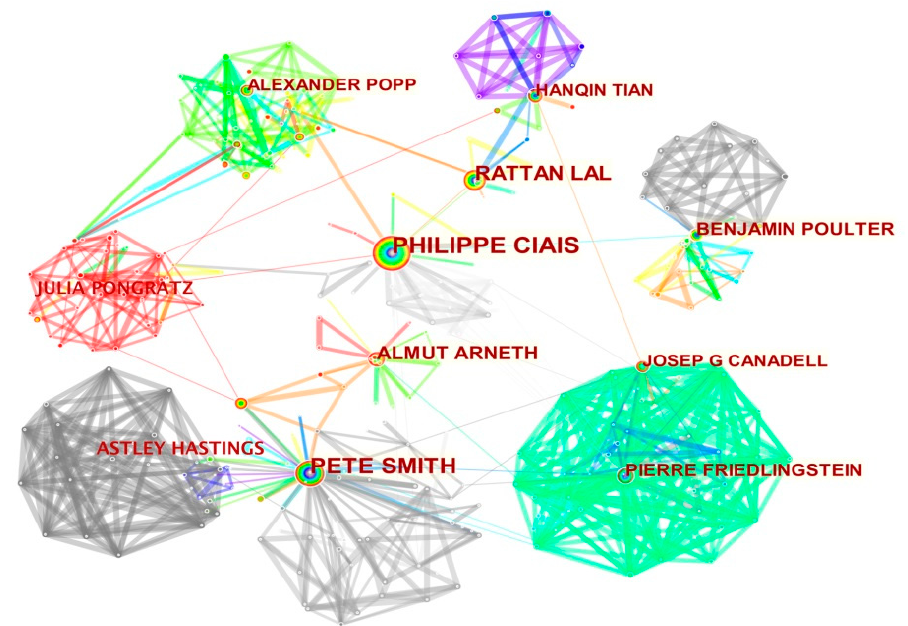
Figure 5. The collaborative network of authors for carbon emissions research in the WoS database. Based on the CNKI database, the authors’ cooperation network graph with a net- work density of 0.0032, a node number of 417, and a connection number of 281 were obtained. According to Figure 6, the cooperation team centered on Huang Xianjin of Nanjing University (23 papers) and Zhao Rongqin of the North China University of Water Resources and Electric Power (20 papers) are closely connected. They form a core force in land-use carbon emissions research. From 2010 to 2015, Chen Yinrong of sity (13 papers), Yuan Kaihua (6 papers) and others cooperated closely. Yang Xuhong of the Zhongnan University of Economics and Law (16 papers) and Jin Xiaobin (16 papers) and Zhou Yinkang (16 papers), both of Nanjing University, began working together in 2005, and there may be a continuous output of cooperative works in the future. Although Zhou Shenglu and Xu Kang, from Nanjing University, and Yu Guirui, Han Bin and others were not very productive, they formed a close cooperation team from 2000 to 2005. Currently, more authors are working independently than